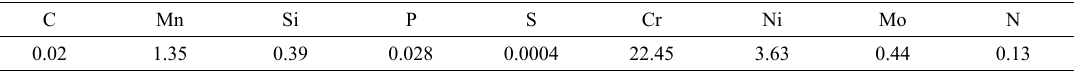
Table 1. Chemical composition of UNS S32304 steel (wt.